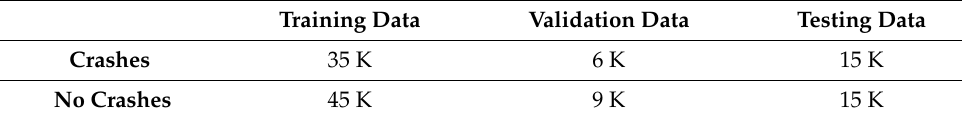
Table 2. Number of Samples.